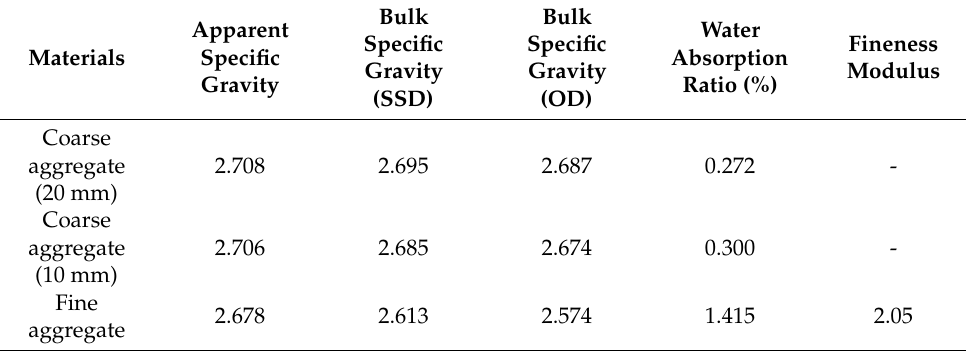
Table 3. Physical properties of coarse and fine